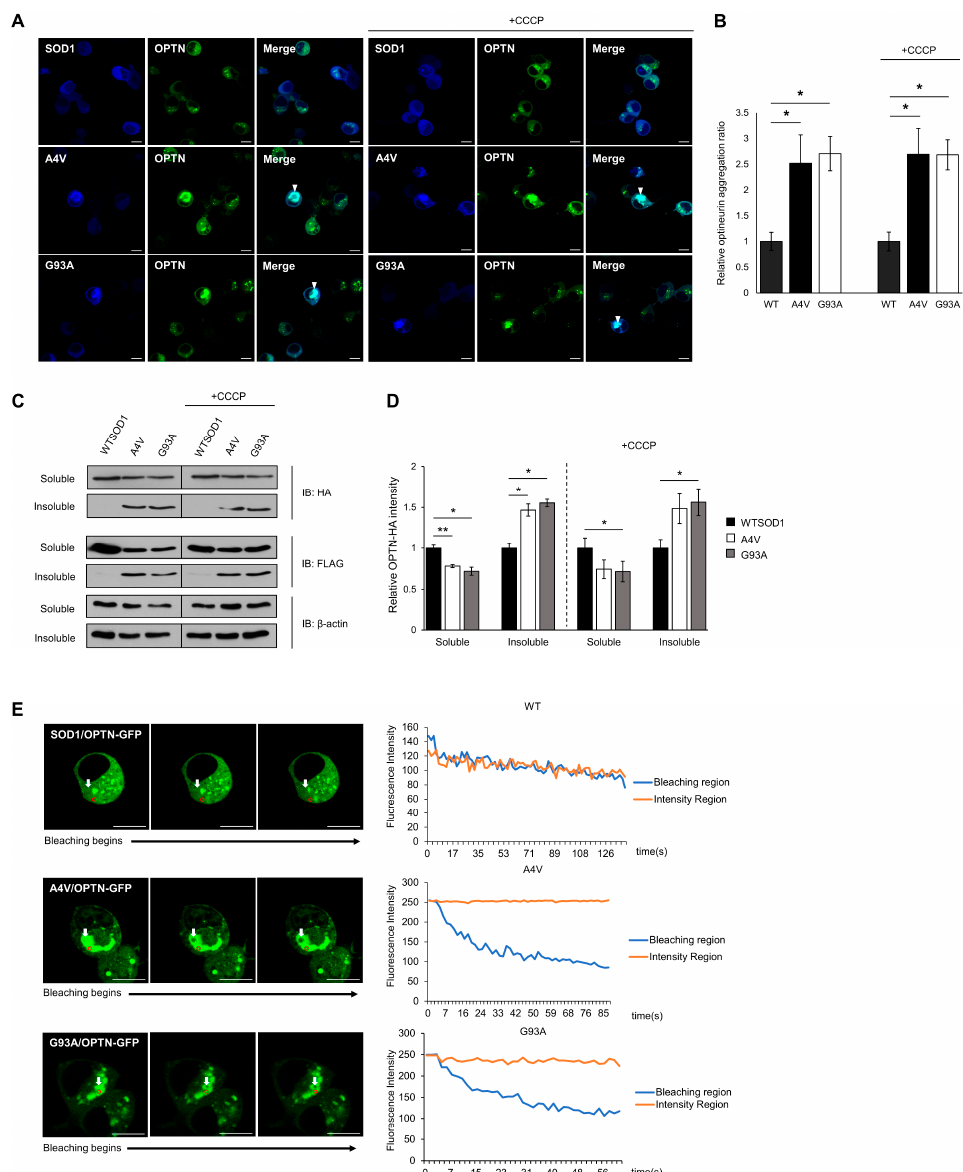
Figure 2. Insoluble optineurin significantly increases in cells with mutant SOD1 aggregates. ( A , B ) Counting the number of intracellular OPTNs enriched with SOD1 aggregates in the presence or absence of CCCP treatment (20 μ M, 2 h). N2a cells were transiently transfected with OPTN-GFP and Cerulean tagged wild type or mutant SOD1 (A4V, G93A) for 48 h. Arrows indicate OPTN co-aggregated with SOD1. n = 250–300 cells per group. Scale bar = 10 μ M. ( C , D ) Quantitation of soluble and insoluble OPTN in cells transiently transfected with HA-OPTN and FLAG-tagged SOD1, A4V or G93A. At 48 h after transfection, the lysates separated into a soluble and insoluble fraction. Each sample was immunoblotted with anti-HA, anti-FLAG, and anti- β -actin antibody. The results were normalized to β -actin. The results reflect three independent experiments. * p < 0.05. ** p < 0.01. ( E ) For FLIP assay, N2a cells were transiently transfected with OPTN-GFP together with FLAG-SOD1, FLAG-A4V, or FLAG-G93A. At 48 h after transfection, each cell was bleached, and the intensity of OPTN-GFP was measured. The white arrow indicates regions where bleaching was performed, and the fluorescence in the red circle was measured. Scale bar = 10 µ